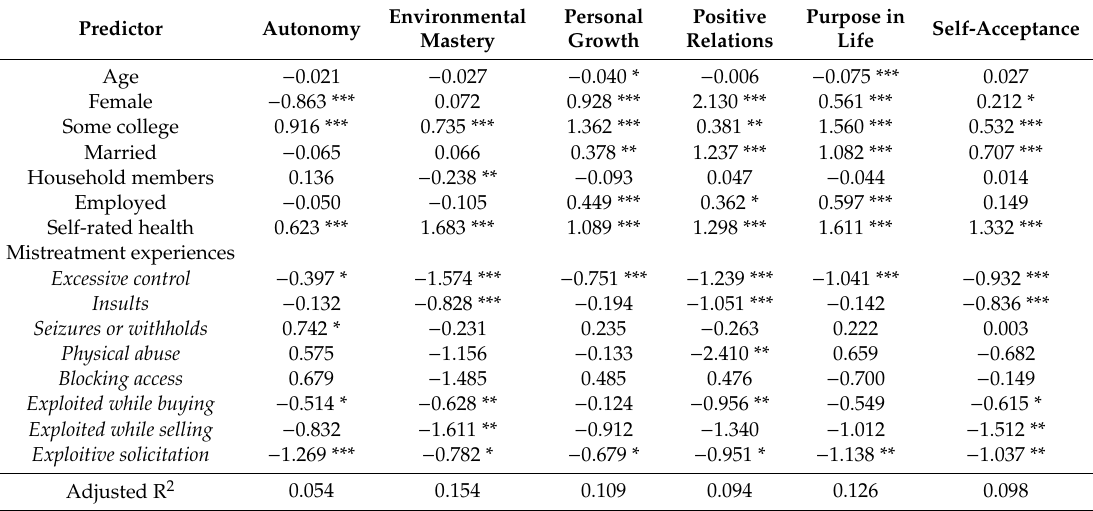
Table 6. Full OLS regression models with demographic controls included 1